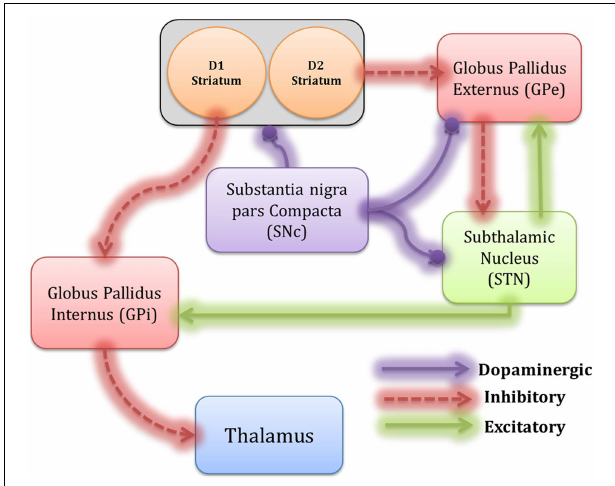
FIGURE 1 | The architecture of the proposed spiking neural Basal Ganglia model, which includes Striatum, GPe, GPi, STN, thalamus, and SNc. The inhibitory connections are represented by dotted lines and the excitatory connections by solid lines. The modulatory effect of DA is shown by the solid line with a